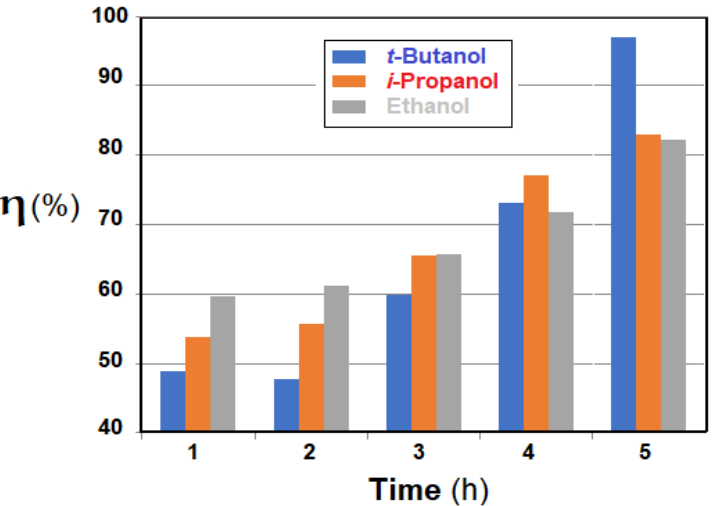
Figure 18. Conversion ( η %), as a function of time, of 10-undecylenic acid after molecular oxygen oxidation on the osmium nanoparticles-polypropylene hollow fibers (Os-PP2) composite membrane, for selected primary alcohols.